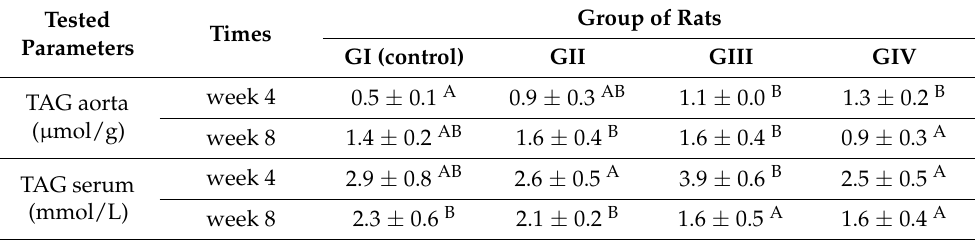
Table 3. TAG accumulation in tissues. Tested Parameters